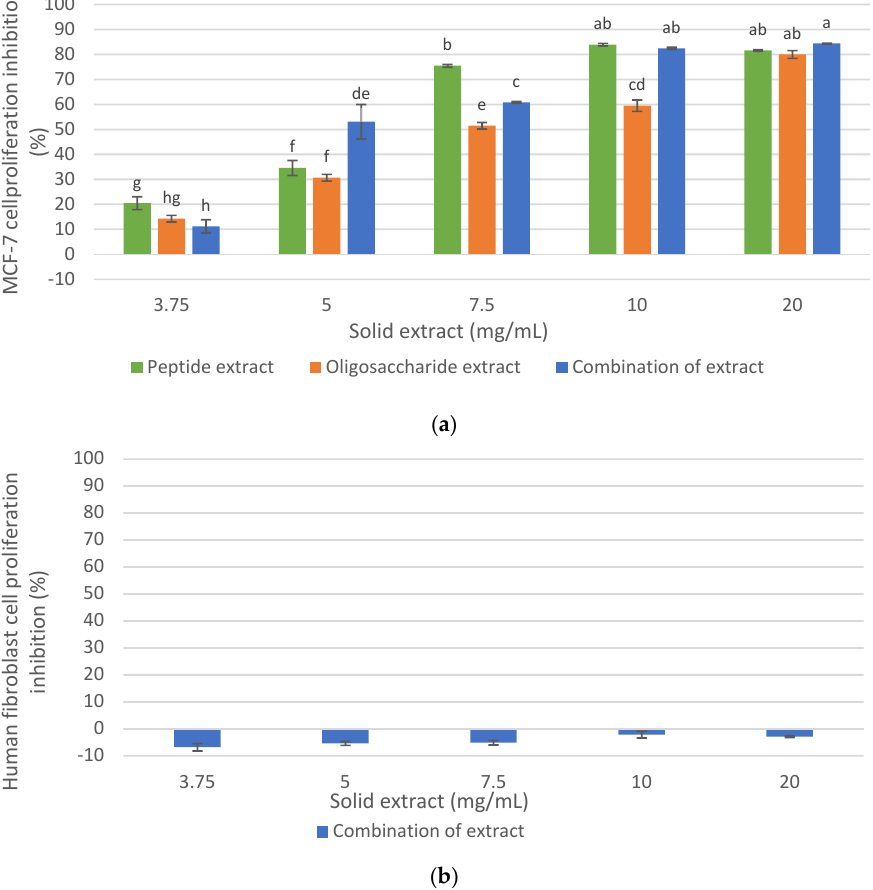
Figure 6. Effect of the combination of oligosaccharide extract and protein extract obtained from DRM on the cellular inhibition. ( a ) on MCF-7 cancer cell line. ( b ) on human fibroblast cell. Mean ± SD ( n = 3). The median that does not share a letter are significantly different ( p > 0.05), comparing all values together with ANOVA and Tukey’s test.